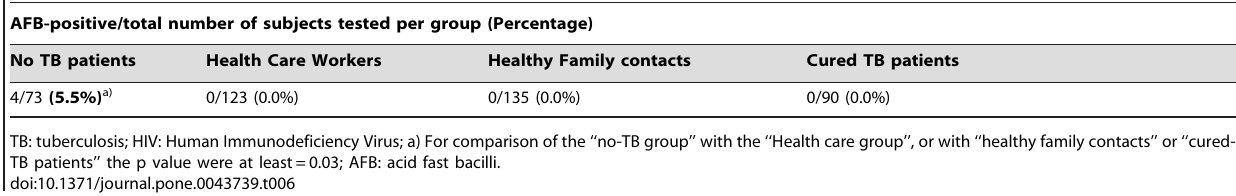
Table 6. Frequency of smear microscopy positive results of adult high-risk controls studied.